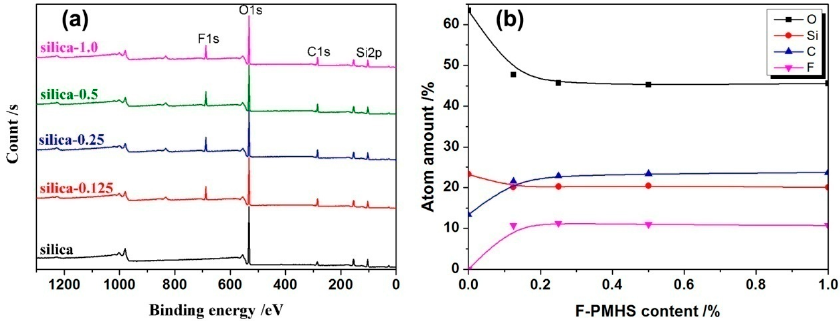
Figure 2. XPS spectra of silica ARC before and after F-PMHS modification ( a ), and the effect of F-PMHS content on the atom amounts of ARCs ( b ).